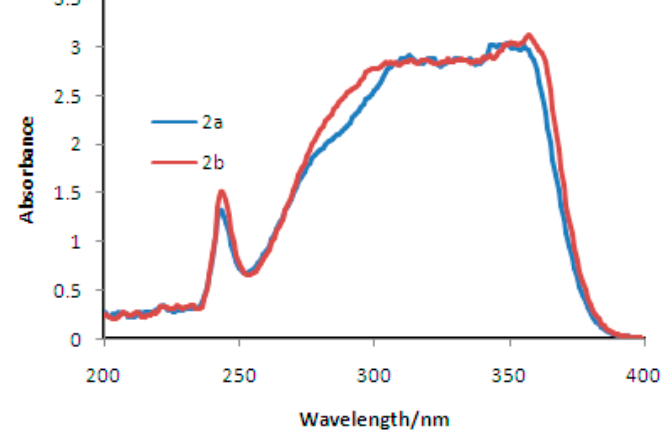
Figure 2. UV-Visible spectra of the complexes 2a and 2b .